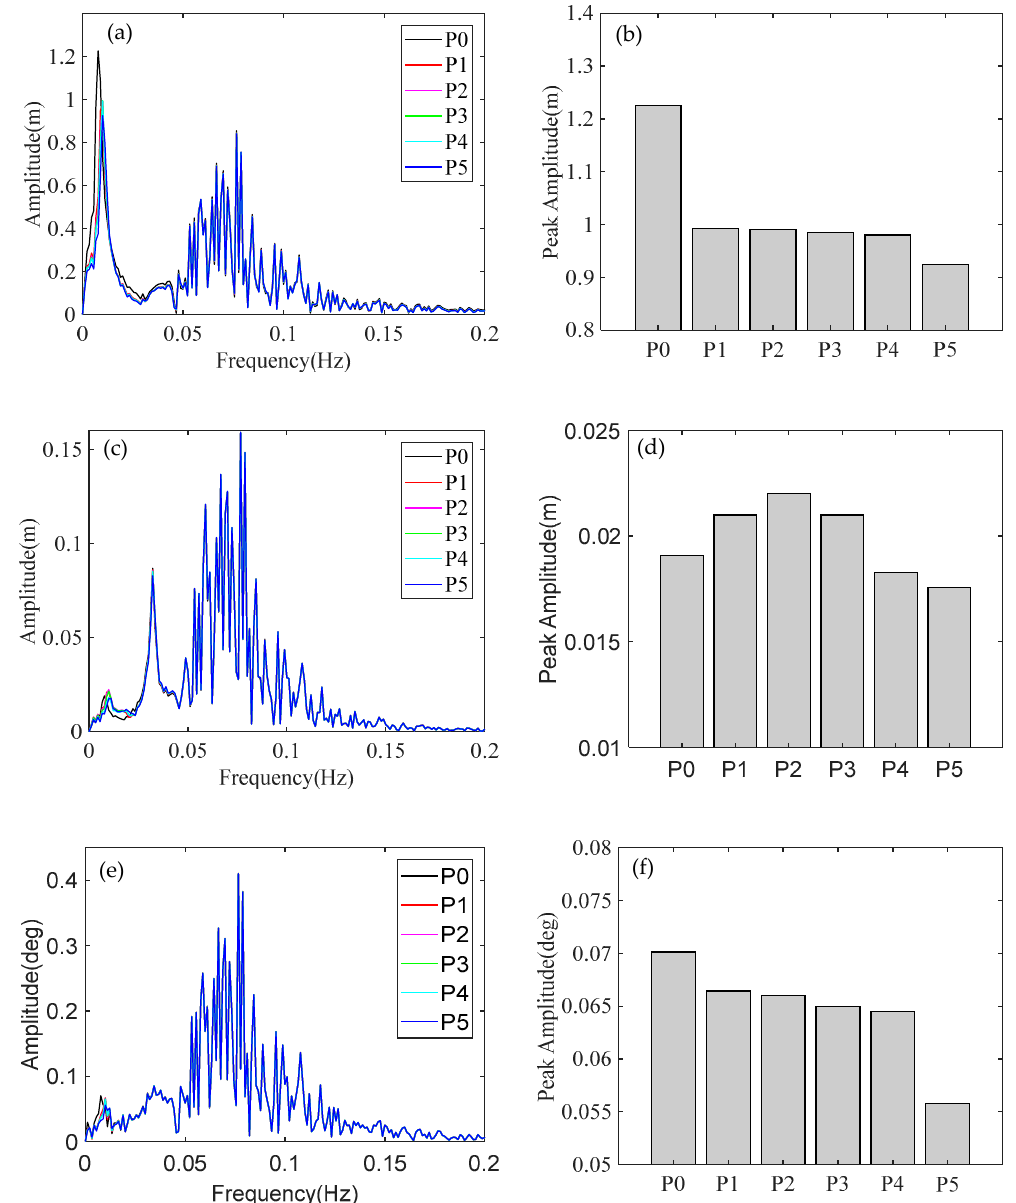
Figure 13. Frequency domain amplitude at load case 6 for ( a ) surge, ( c ) heave, and ( e ) pitch, and the peak amplitudes for ( b ) surge, ( d ) heave, and ( f ) pitch.